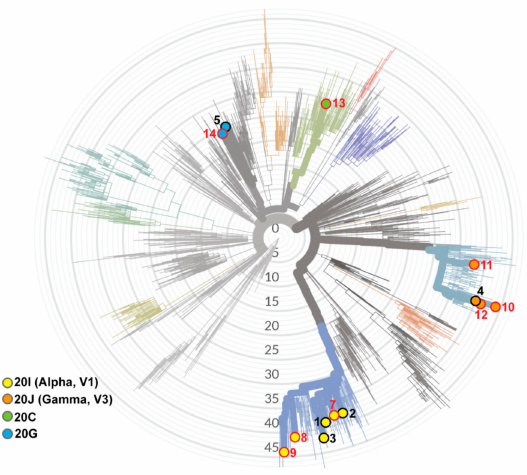
Figure 1. Sequence analyses reveal multiple lineages of SARS-CoV-2 variants associated with break- through infections in this study. Phylogenetic tree depicting the lineages of the thirteen SARS-CoV-2 genomic sequences. The complete genome nucleotide sequence obtained from each subject was analyzed with NextClade software (https://clades.nextstrain.org/tree, accessed on 21 July 2021) for clade assignment. WHO designation of variants of concern (VOC) are given in parenthesis. Hospitalized subjects are indicated with a red circle and number; subjects with mild/asymptomatic disease are indicated with a black circle and number.